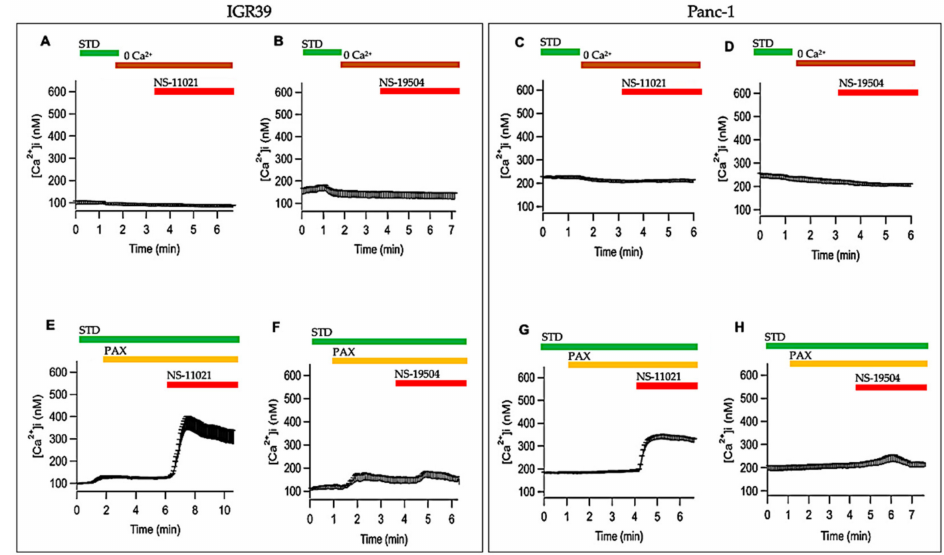
Figure 9. Effects of calcium free bath solution or paxilline on NS-11021- and NS-19504-induced calcium increase. Average [Ca 2+ ] i signal in IGR39 ( A , B ) and Panc-1 ( C , D ) cells after the application of 10 µ M NS-11021 or NS-19504 in STD 0 Ca 2+ . Average [Ca 2+ ] i signal in IGR39 ( E , F ) and Panc-1 ( G , H ) cells after the application of 10 µ M NS-11021 or NS-19504 in STD solution containing 1 µ M PAX. Data ± SE are 220 ± 55 nM ( n = 38) for IGR39 and 145 ± 20 nM ( n = 45) for Panc-1. Horizontal bars indicate the time period of exposure. ( n ) refers to the number of cells.